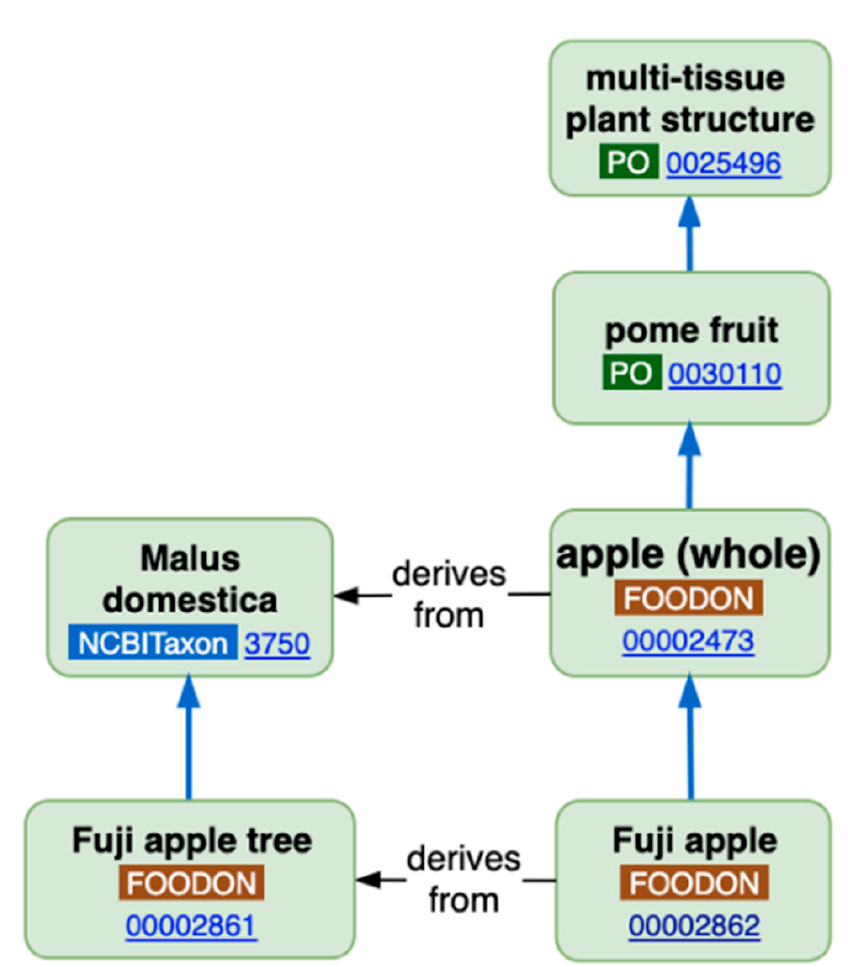
Figure 2. A basic food product, in this case an apple, can be a simple anatomical part, in this case a pome fruit, deriving from a particular plant species (Malus domestica) of a specific variety (Fuji). Reprinted with permission from ref. [26,27]. 2017. Roger A Smith